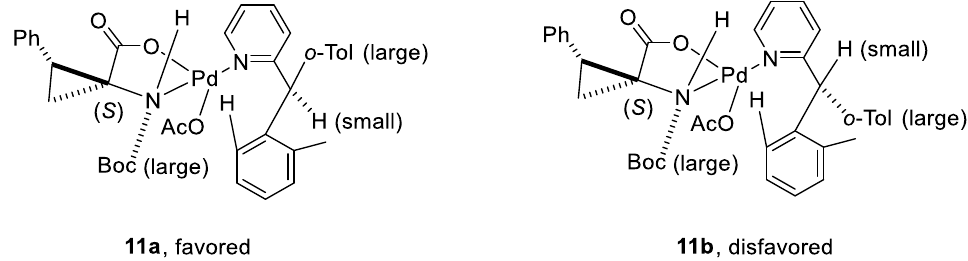
Figure 2. Key intermediates in the proposed mechanistic model. Reproduced from Reference [62].